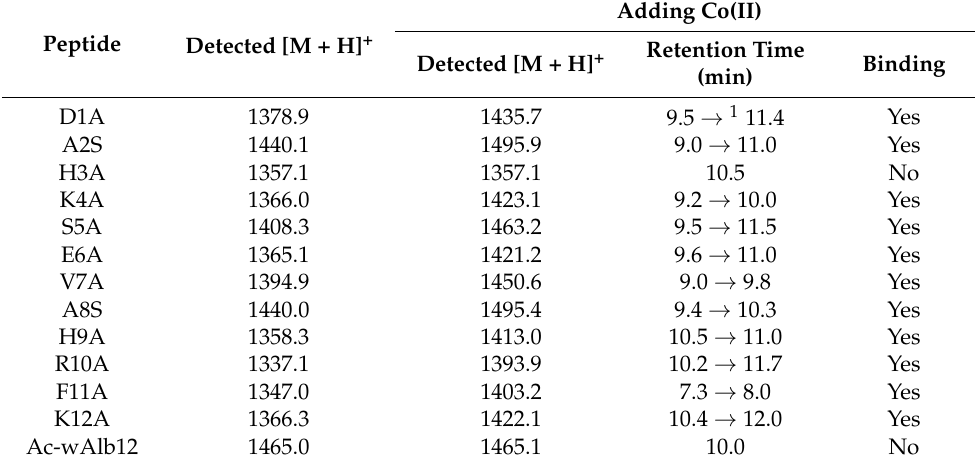
Table 2. MS and analysis of cobalt binding with alanine scanning